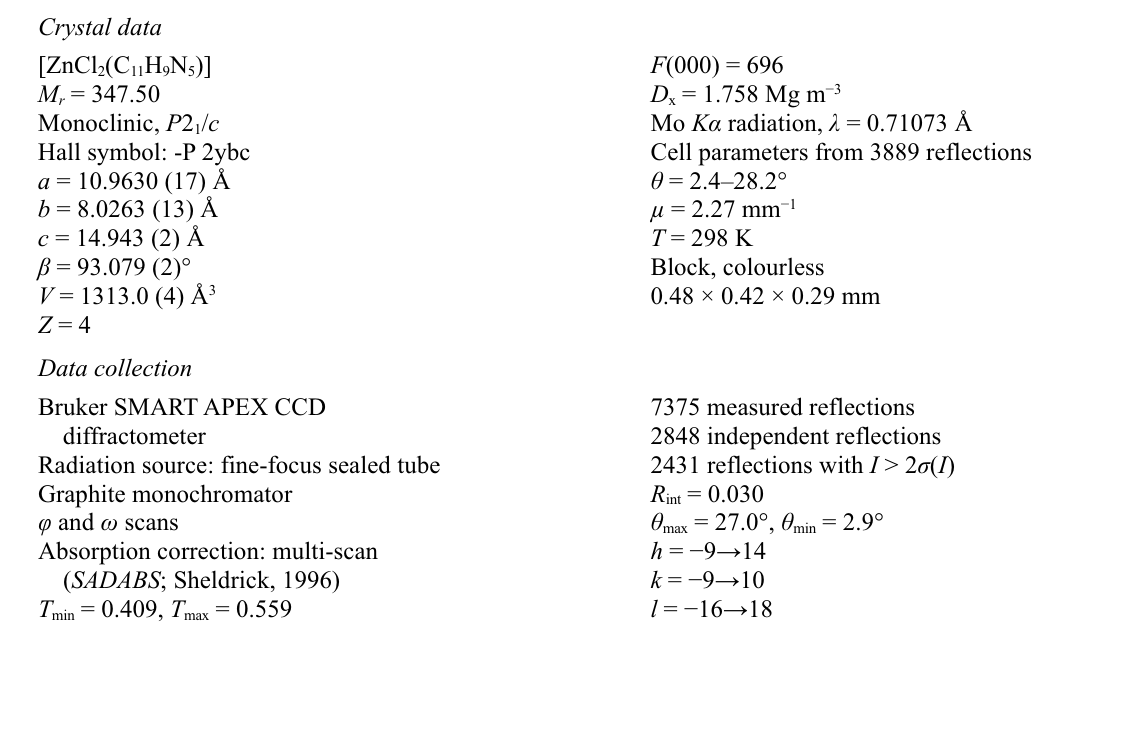
The molecular structure of (I) showing the atomic numbering and 30% probability displacement ellipsoids.